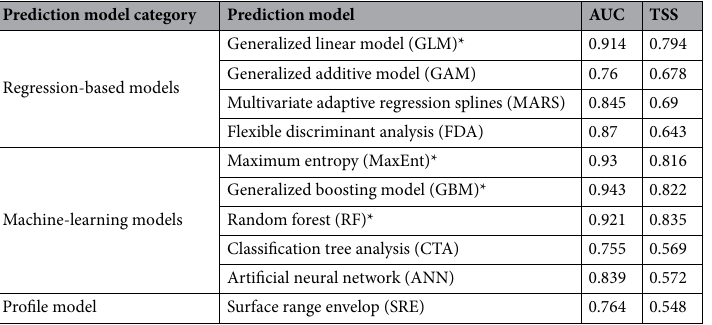
Table 2. Different prediction models used for habitat modeling of the striped hyaena in the study area. *Selected for final habitat